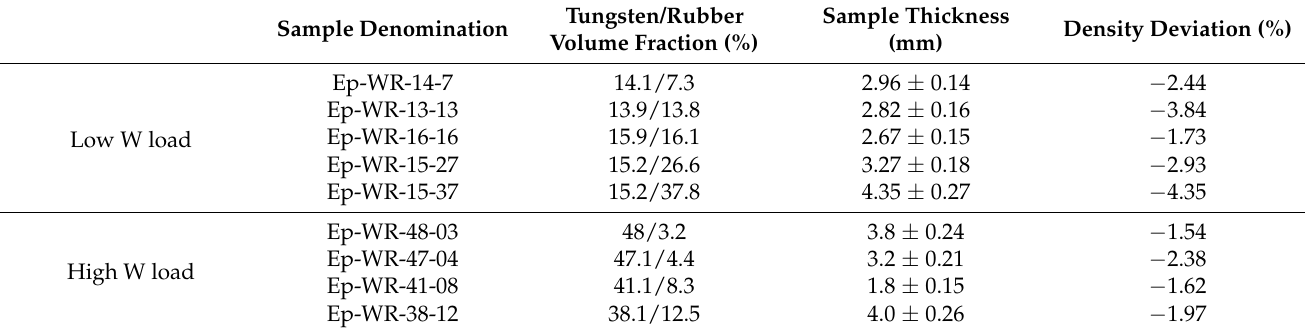
Table 6. Tungsten powder + rubber-powder-loaded epoxy resin composites.